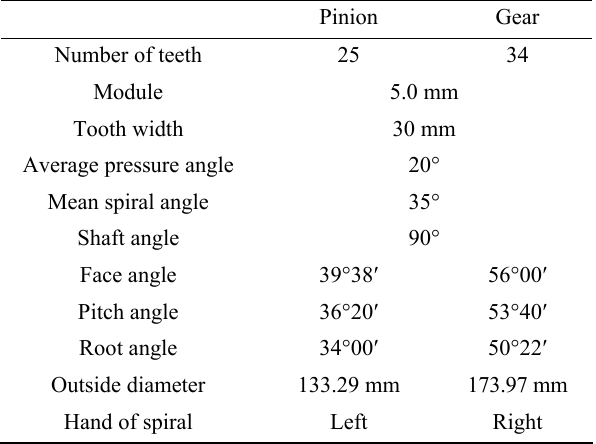
Table 1 Parameters of gear and